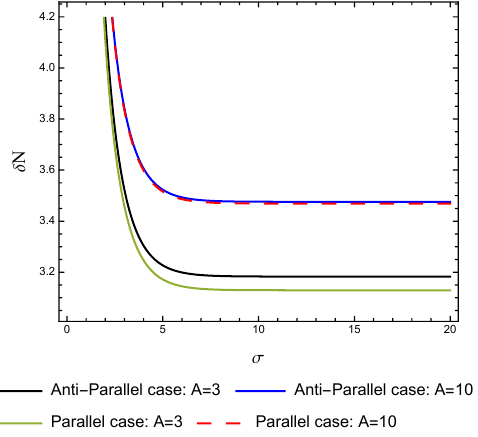
Figure 28 . Parallel and Anti-parallel motions in (1 + 3) dimensions with thermal background: δ N Vs σ plot with ∆ E = 1 , A = 3 . a B